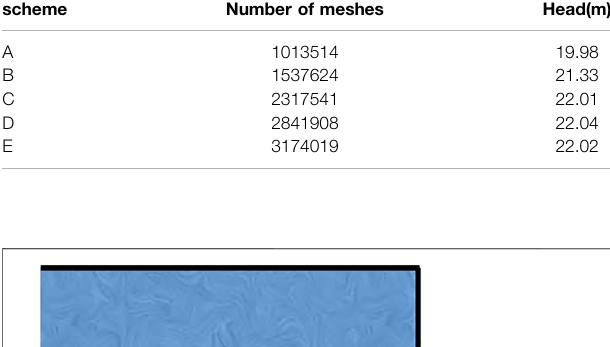
TABLE 2 | Grid model parameters of centrifugal pump. scheme